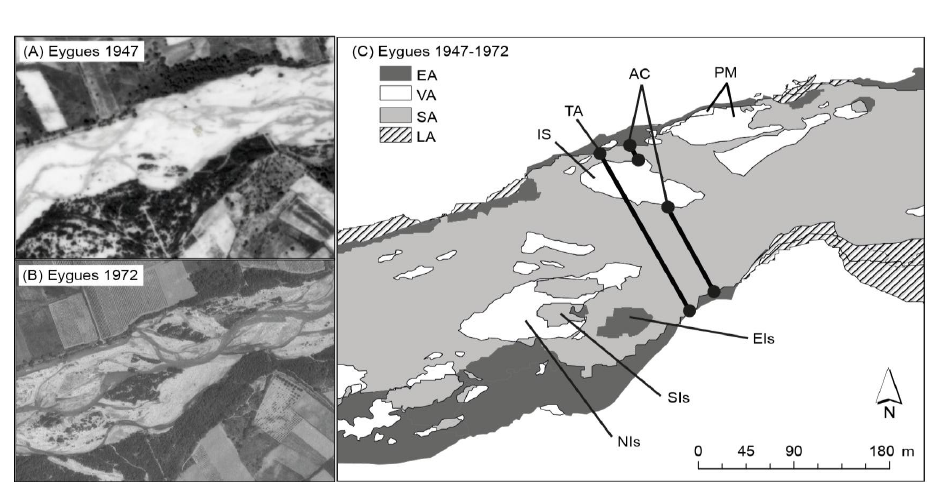
Fig. 2. Schema on landscape units and turnover features. Extract from the Eygues river reach between 1947 and 1972: (A) The Eygues in 1947; (B) The Eygues in 1972; (C) Sketch of landscape units and landscape turnover features: EA = eroded area over the period; VA = vegetated area over the period; SA = stable area over the period; LA = lost area over the period within the natural corridor; AC = active channel width (i.e. water channels and gravel bars); IS = island; TA = total active channel (i.e. AC + IS); PM = pioneer margins; NIs = new island; SIs = stable island; EIs = eroded